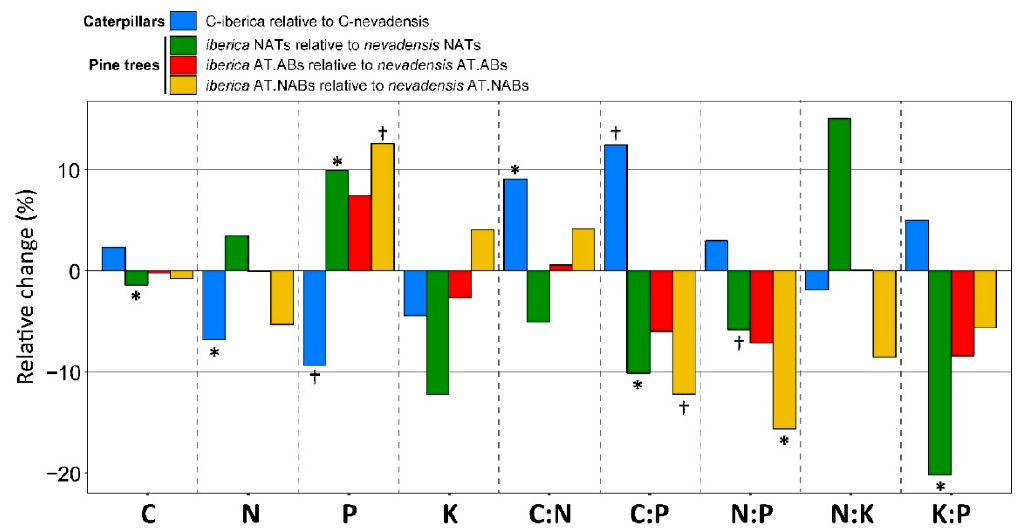
Figure 2. Relative difference (%) of elemental and stoichiometric variables between caterpillar groups (C-iberica relative to C-nevadensis) and between pine subspecies for each folivory level ( iberica NATs relative to nevadensis NATs; iberica AT.ABs relative to nevadensis AT.ABs; iberica AT.NABs relative to nevadensis AT.NABs). Positive values indicate higher elemental concentration or stoichiometric ratio value in C-iberica or iberica trees while negative values indicate higher elemental concentration or stoichiometric ratio value in C-nevadensis or nevadensis trees . Asterisks and crosses denote statistical significance (* p < 0.05) and marginal significance ( † p < 0.1), respectively.